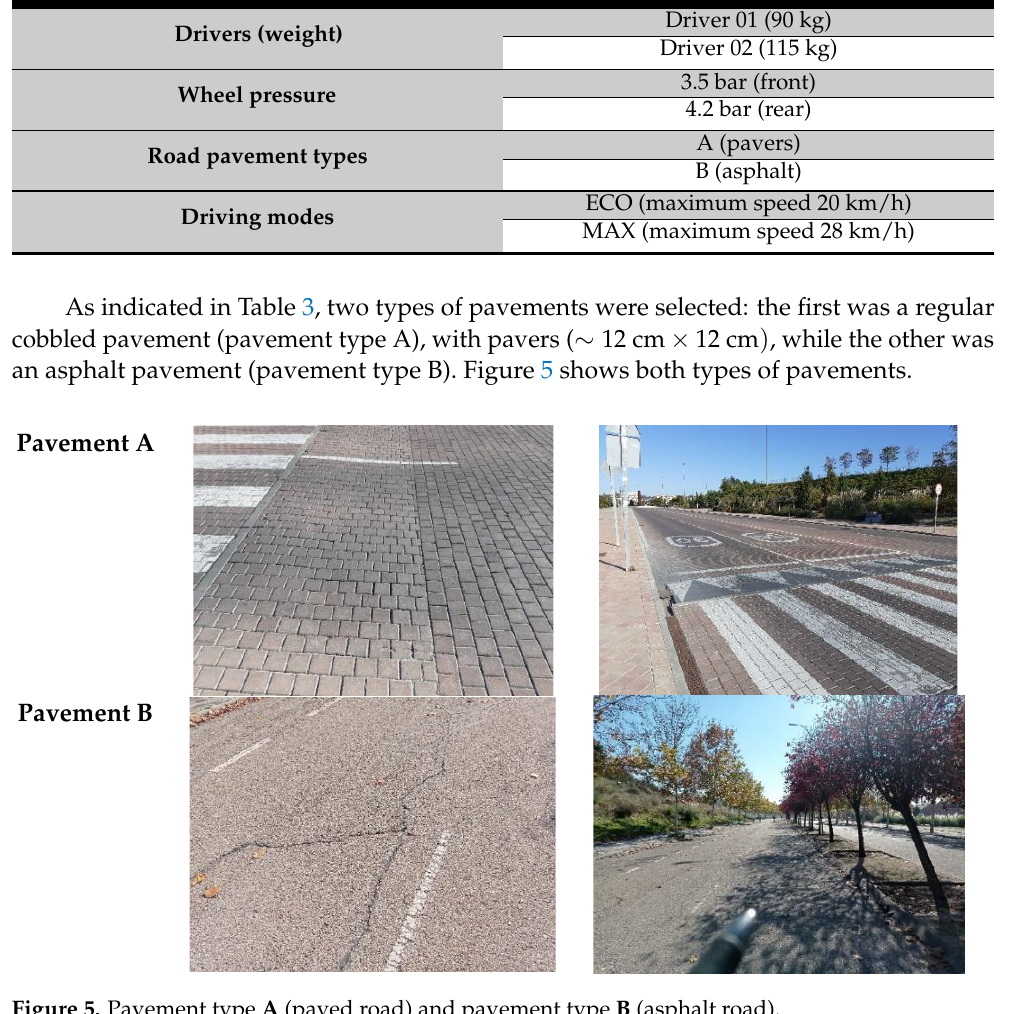
Figure 5. Pavement type A (paved road) and pavement type B (asphalt